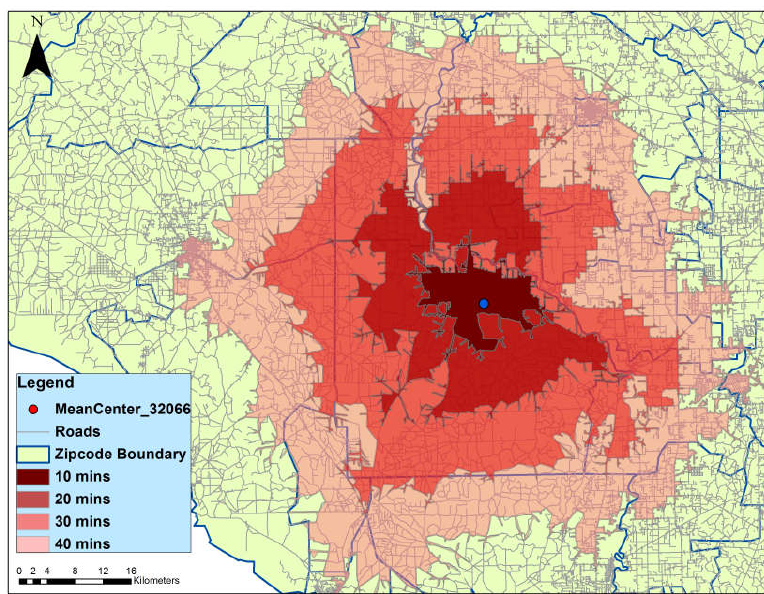
Figure A2. Travel rings of 0–10, 11–20, 21–30, and 31–40 min around the population mean center of a ZIP code area 32066, created based on a real road network.